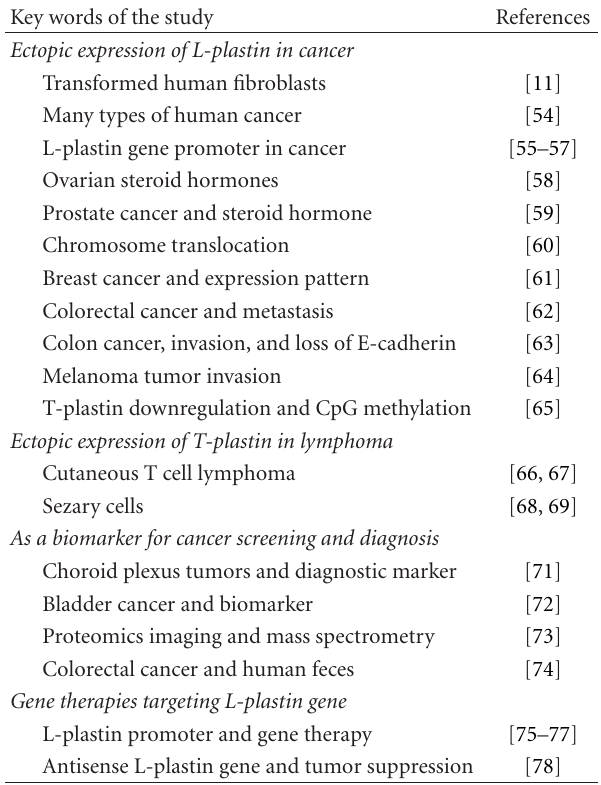
Table 5: Studies on plastins in cancer